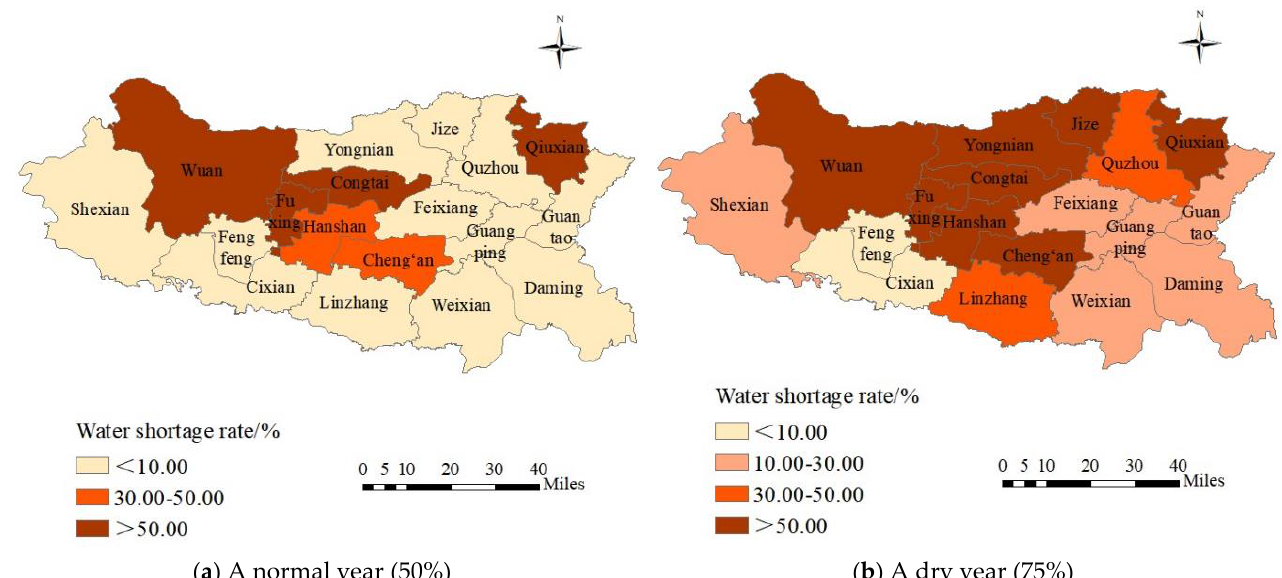
Figure 13. Agricultural water shortage in 2025.